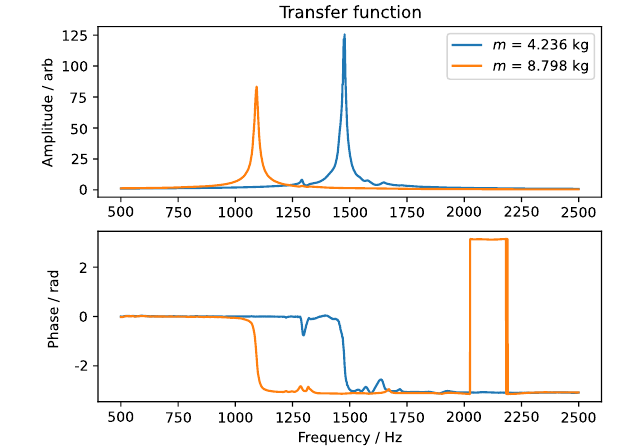
Figure 12. Amplitude and phase of the transfer function H ( f ) for excitation in F z .